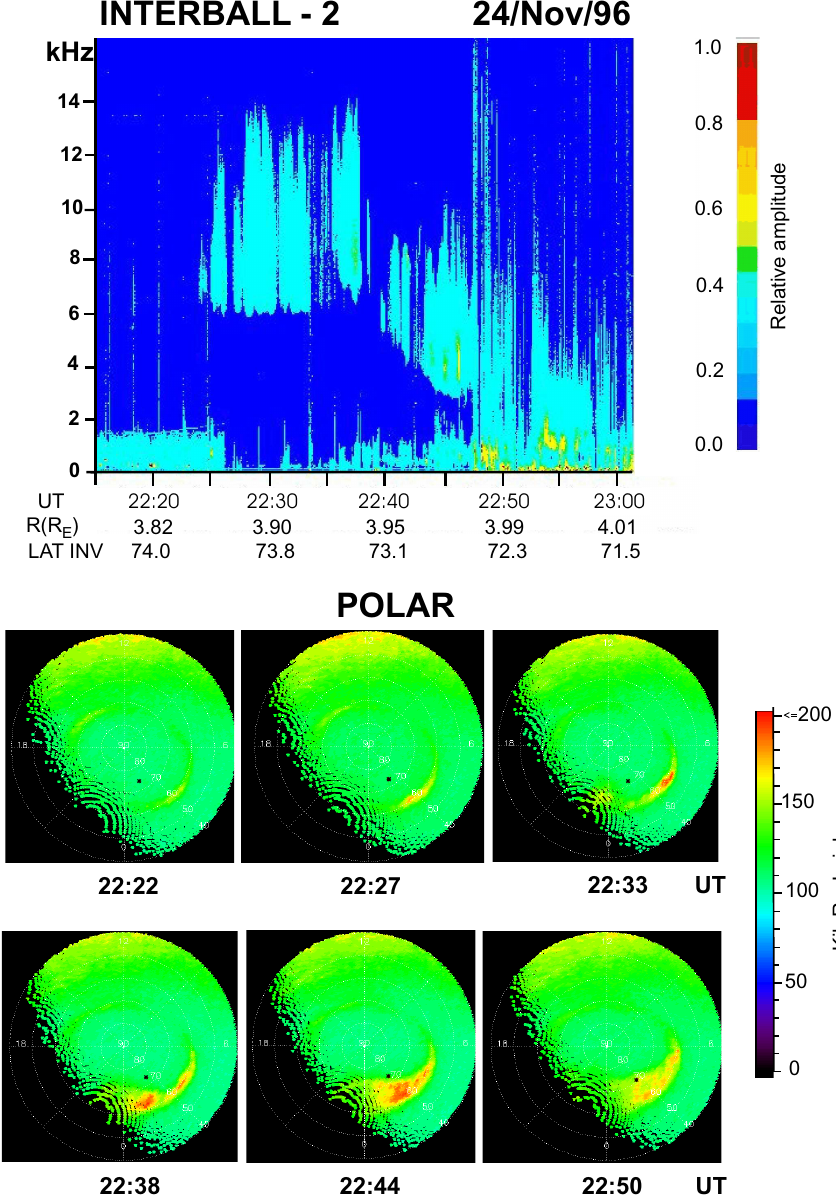
Fig. 5. Upper panel: spectrogram of the electric component of VLF waves recorded by INTERBALL-2 on 24 November 1996 during the development of a strong substorm. Bottom panel: sequence of auroral images obtained by POLAR satellite VIS imager. The images are in InvLat-MLT coordinates. The INTERBALL-2 footprint is indicated by black